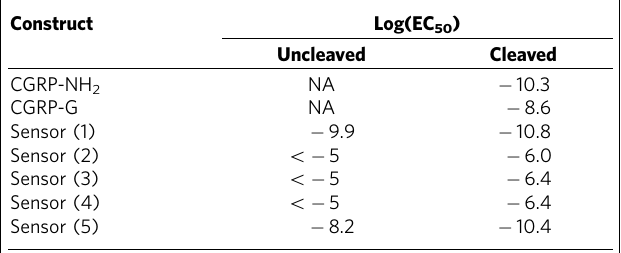
Table 1 | Effect of cleavage on the potency of CGRP-based protease sensors.